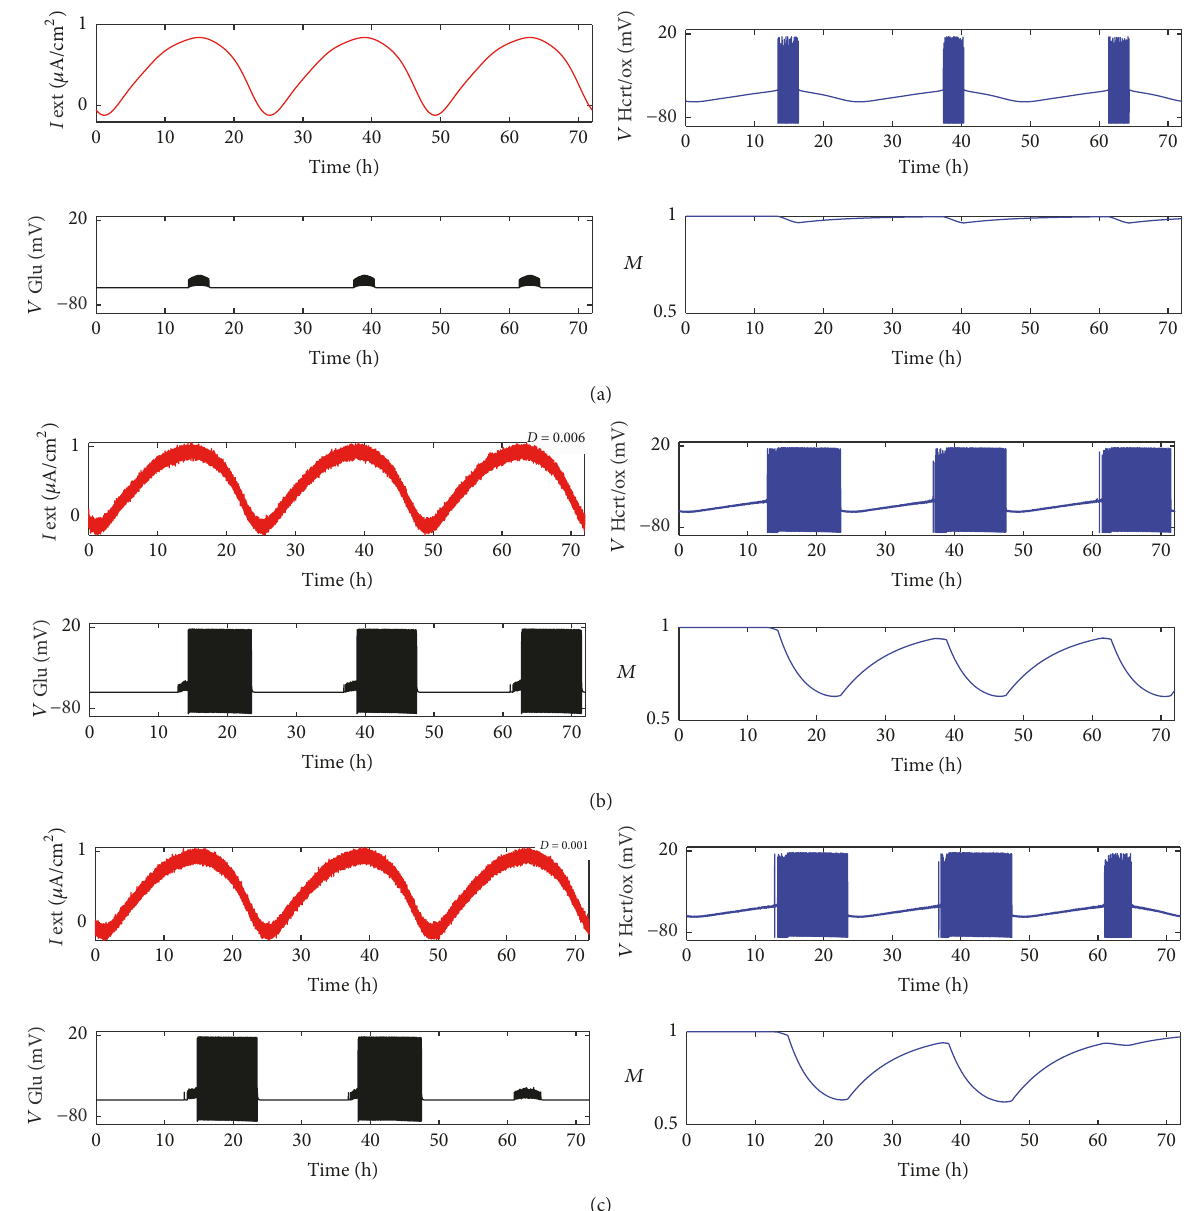
Figure 2: In subthreshold regime, the amplitude of external current input is set to 𝐴 = 0.46 𝜇 A/cm 2 to the deterministic regulation of sleep- wake cycles model stimulus which only can excite Hcrt/ox neuron, but the Glu neuron just displays the subthreshold activities (a), but, after an additive Gaussian white noise is added to current, leading to the seemingly random regulation process, it sometimes shows similar regulation function (b) (where the noise intensity 𝐷 = 0.006 ); occasionally, the model shows a sudden and terrible change (c) (where 𝐷 = 0.006